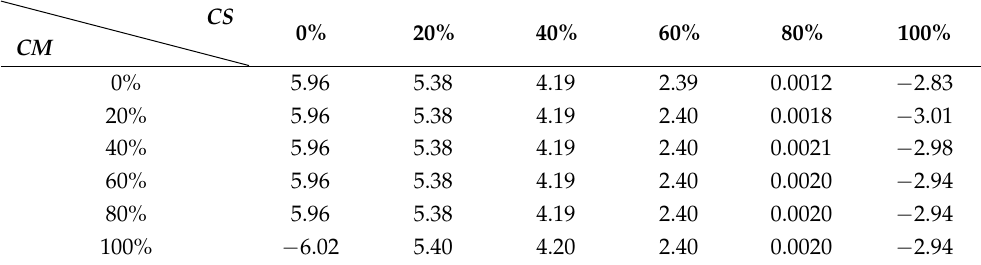
Table 7. Convergence yaw angle for combinations of CM and CS, ( µ rad).